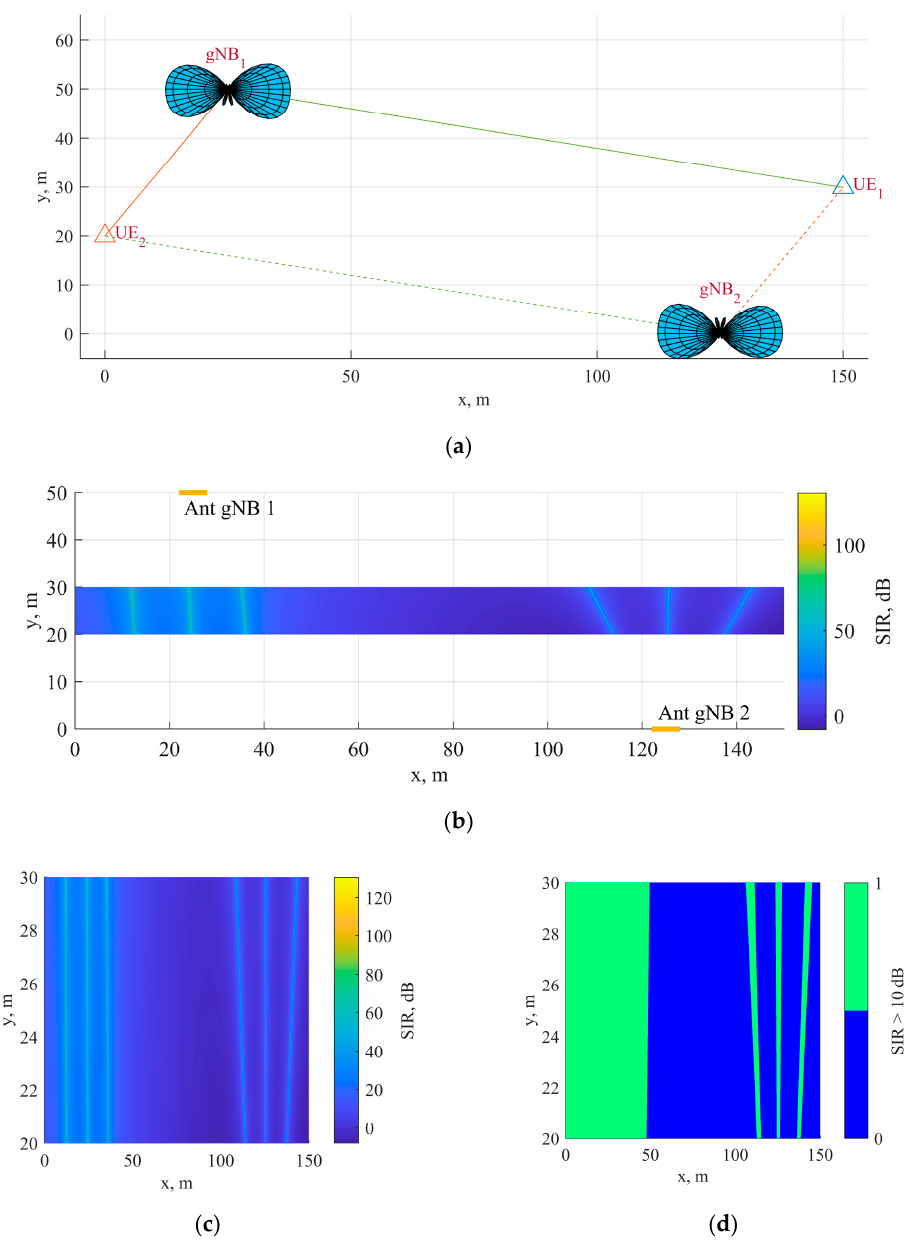
Figure 2. Simulation scenario 2: ( a ) gNB with AA pattern and UE trajectories on the x-y plane; ( b ) Map of UE SIR values with gNB location on the x-y plane; ( c ) Map of SIR values along UE trajectories; ( d ) Map of SIR values exceeding a given threshold along UE trajectories.